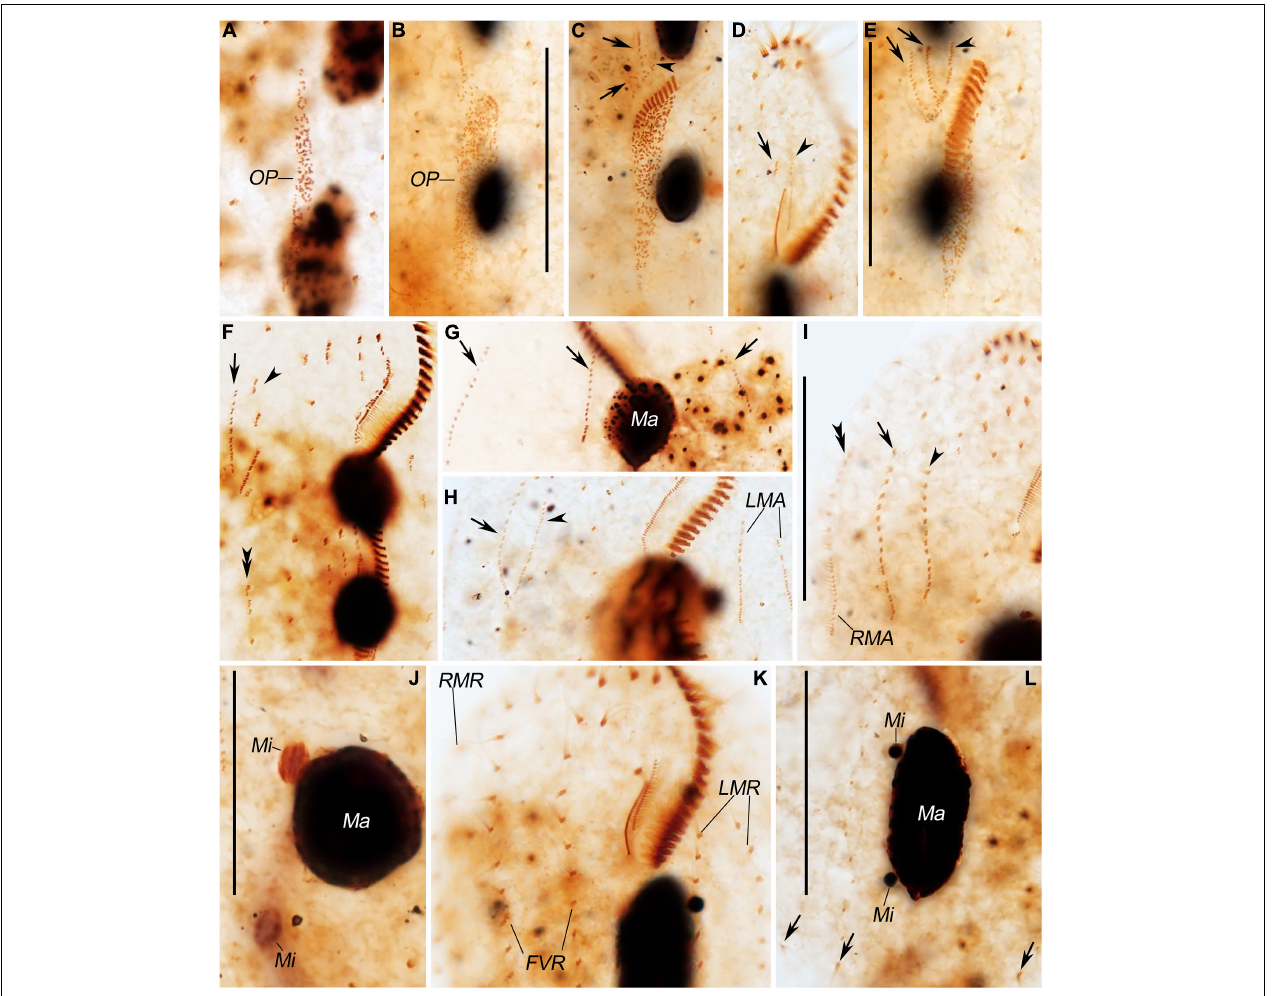
FIGURE 4 | Photomicrographs of Pseudosincirra longicirrata nov. gen. and nov. comb. during morphogenesis after protargol staining. (A,B) Ventral views of very early phases showing the newly formed oral primordium. (C) Ventral view of an early divider; arrows display the FVT-anlagen, while arrowhead marks the undulating membrane anlage. (D,E) Ventral views of a slightly later divider. In panel (D) , the arrow and arrowhead mark the dedifferentiation of buccal cirrus and the parental paroral and endoral, respectively. Arrows and arrowhead in panel (E) show the FVT-anlagen and undulating membrane anlage, respectively. (F,H,I) Ventral views; arrows mark anlage V in the proter, arrowheads denote anlage IV in the proter, double arrowhead in panel (F) reveals anlage V in the opisthe, and double-arrowhead in panel (I) points to the dorsomarginal kinety anlage. (G) Dorsal view; arrows demonstrate the dorsal kinety anlagen. (J) Dorsal view of the same cell as shown in panel (I) , showing the fusion of the macronuclear nodules. (K,L) Ventral and dorsal views of a late divider, arrows in panel (L) indicate the newly formed caudal cirri. FVR, frontoventral rows; FVT-anlagen, frontoventral-transverse cirral anlagen; LMA, left marginal anlagen; LMR, left marginal row; Ma, macronuclear nodules; Mi, micronuclei; OP, oral primordium; RMA, right marginal anlagen; RMR, right marginal row. Scale bars = 40 µ m.